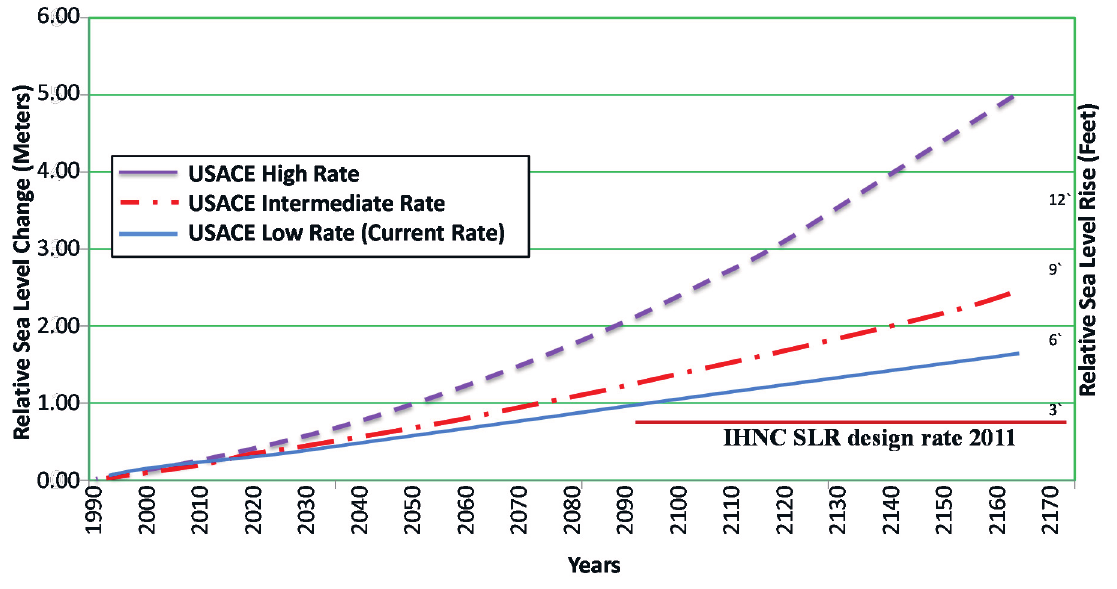
Figure 9. USACE projected sea-level rise curves for Grand Isle, Louisiana. These curves include eustatic (global) sea-level rise values and subsidence rates